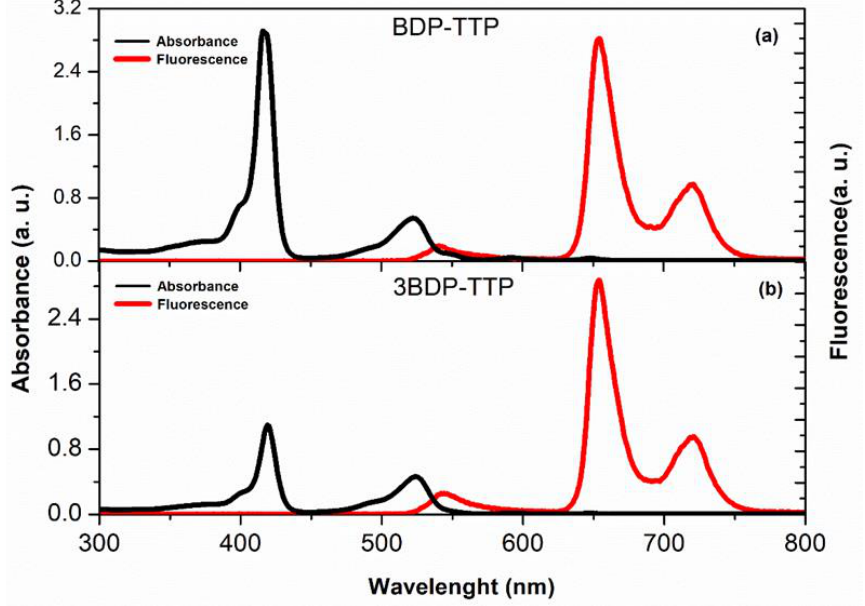
Figure 4. The overlap of the linear absorption and emission spectra of ( a ) BDP – TTP and ( b ) 3BDP – TTP with 524 nm excitation wavelengths.